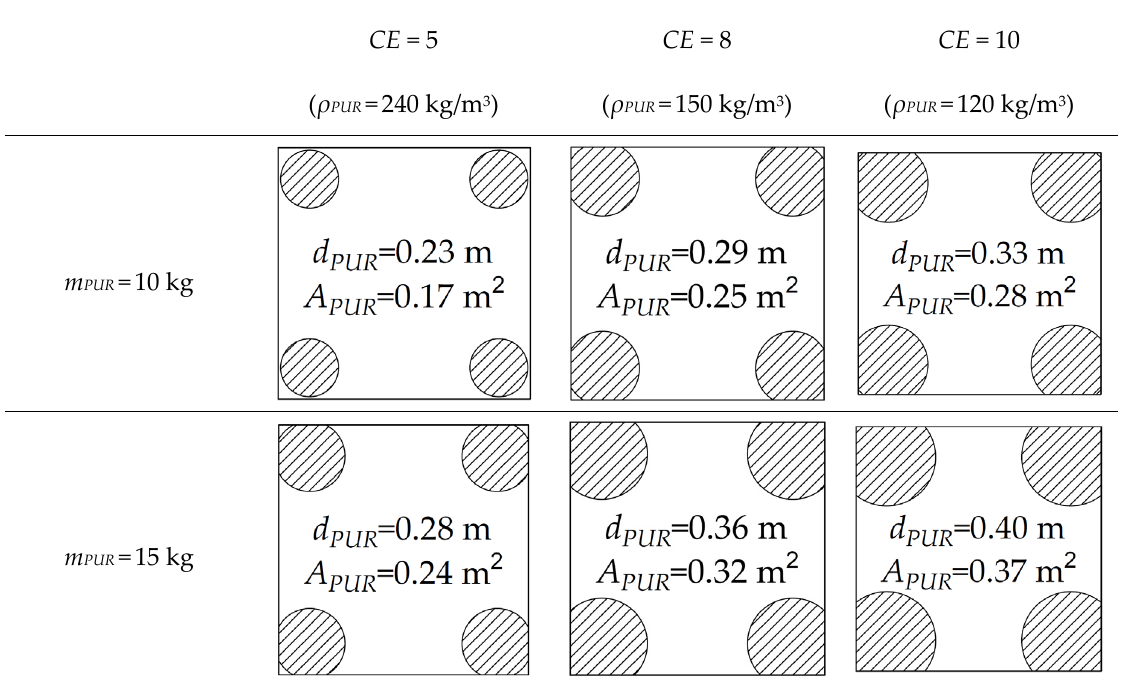
Figure 5. Summary of the injection cases analysed. The polyurethane diameter and area are shown, corresponding to each considered combination injected mass per level, m PUR —expansion coefficients CE .